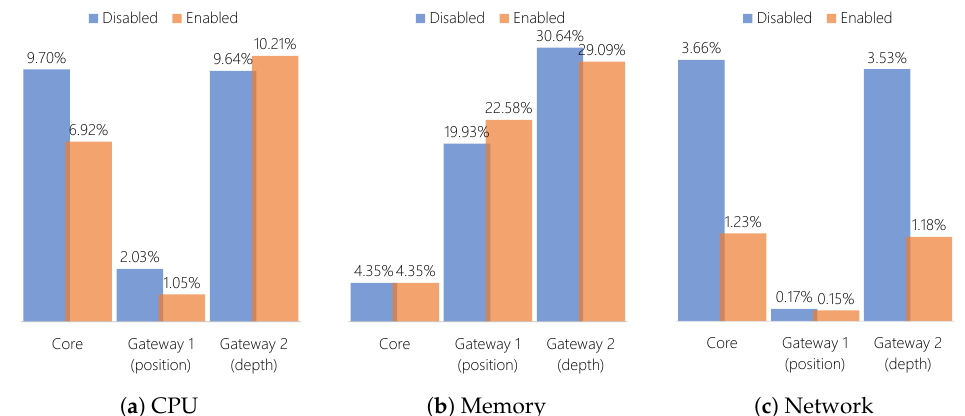
Figure 9. Comparison of resource consumption of each node with the QoS Service Elasticity enabled and